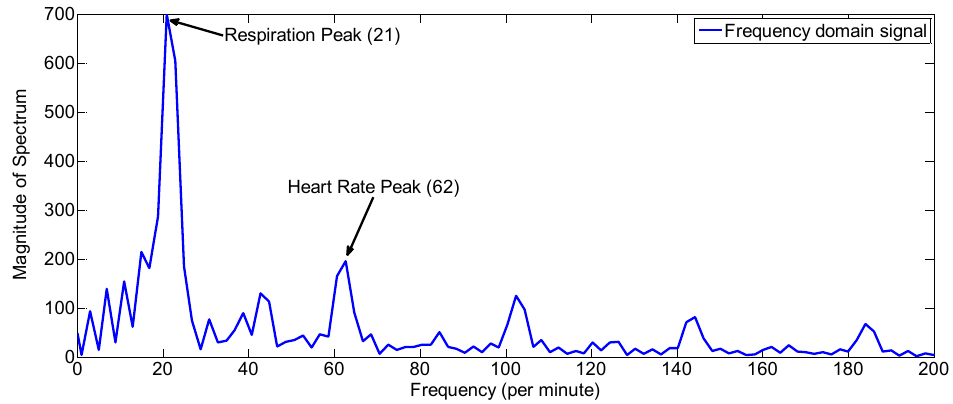
Figure 17. Spectrum obtained by applying FFT algorithm to the signal obtained by proposed algorithm in Figure 16(a).